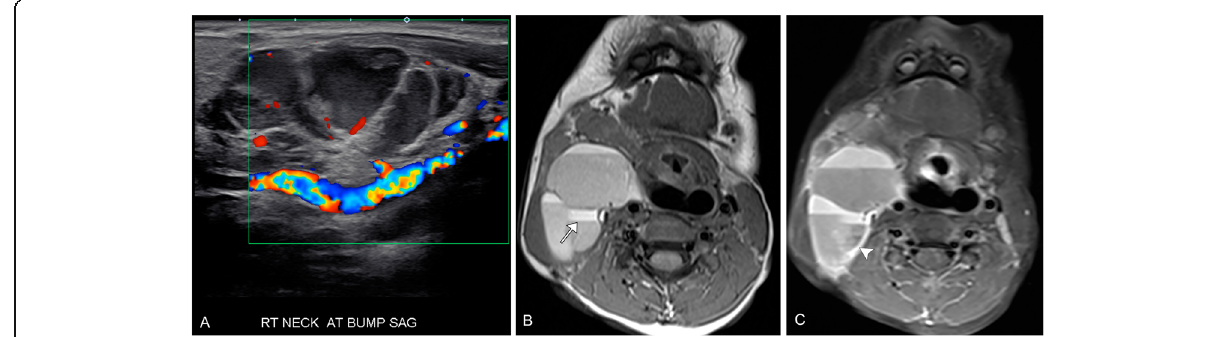
Fig. 9 Macrocystic lymphatic malformation. A 2-year-old male with right neck mass. a US demonstrates a complex multiloculated cystic mass without internal vascularity. b Axial T1 pre-contrast image better demonstrates the multiloculated cystic mass, which has fluid-fluid levels (arrow).